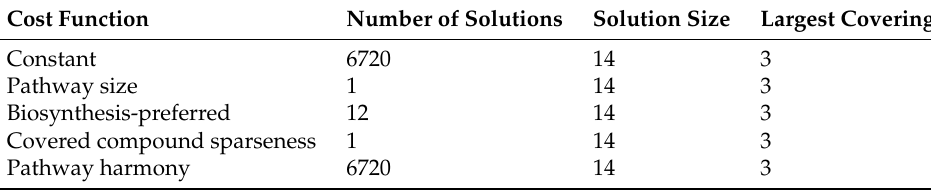
Table 6. Summary of ST00741 Coverings by Cost